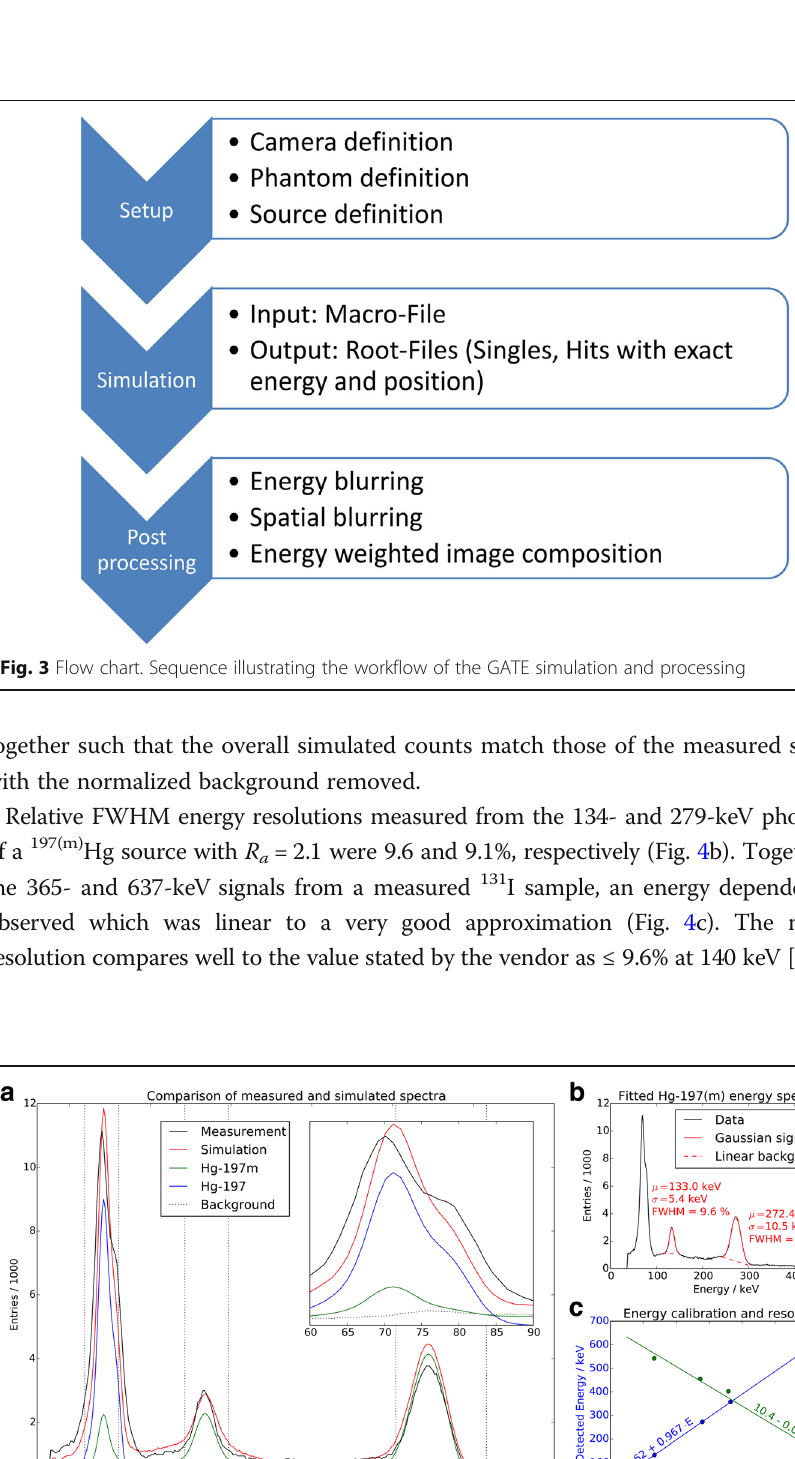
Fig. 4 Energy spectra. Investigation of energy spectra. a Comparison of measured (black) and simulated (red) energy spectra for a sample with activity ratio R a = 2.1. The simulated spectrum contains contributions from both isomers and a background template derived from measurement. Energy windows are marked as dotted vertical lines. b Measured energy spectrum for 197(m) Hg. The center and width of the selected photo-peaks is determined from Gaussian fits and used to derive an energy calibration and determine the energy resolution. c Energy calibration (blue) and resolution (green) derived from measurements of each of two 197(m) Hg and 131 I photo-peaks. Linear fits were obtained to interpolate for arbitrary energy values